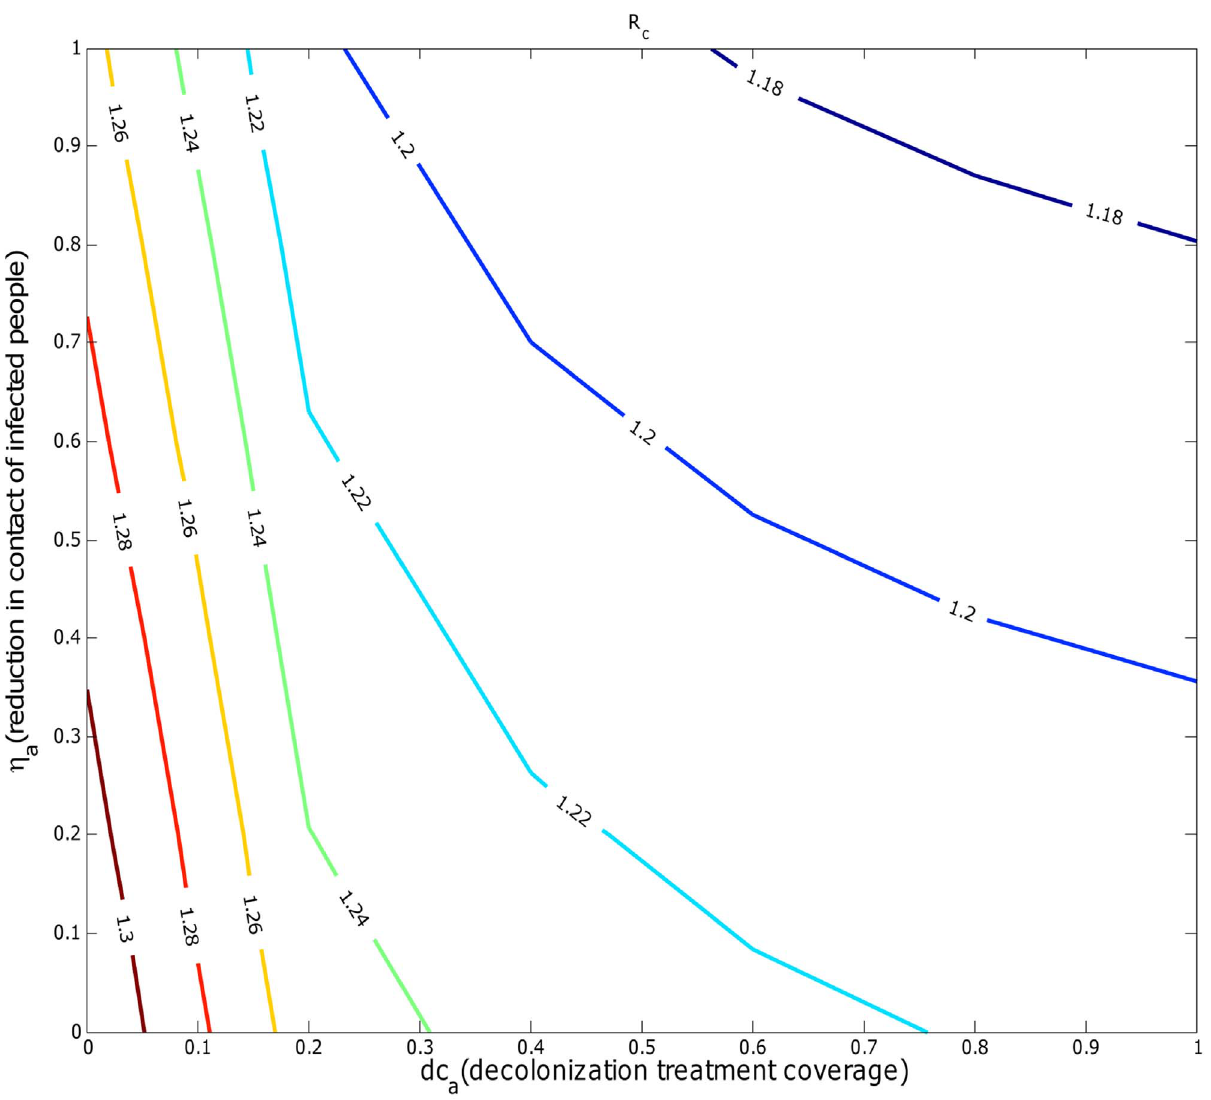
Figure 7. Mean value of R c for a combined strategy of with different levels of reduction in contact of infected individuals ( g a ) and decolonization treatment coverage the infected ( dc a ) in all age groups under parameter uncertainty.